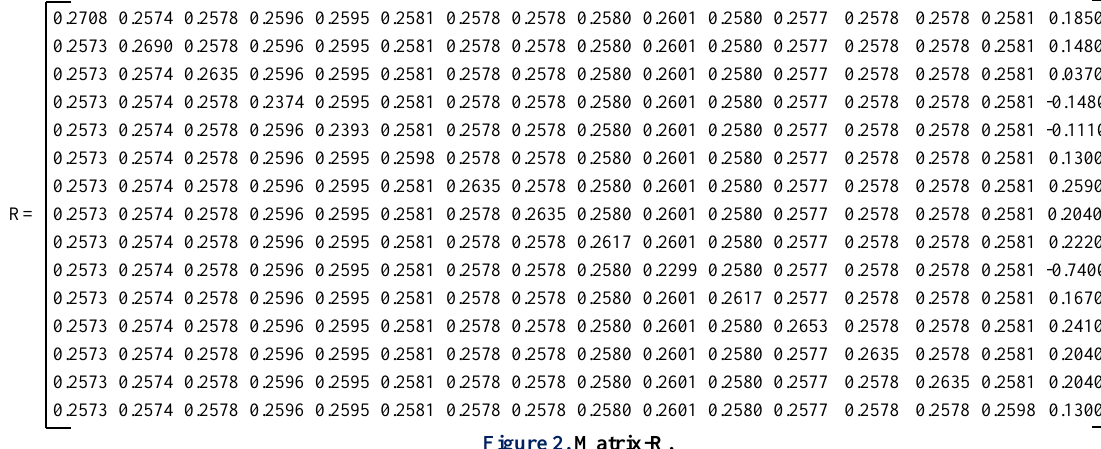
Figure 2. Matrix-R.